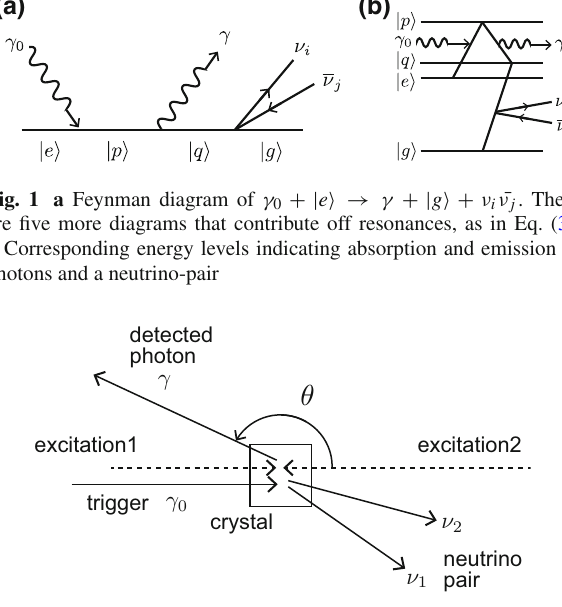
Fig. 2 Schematics of experimental